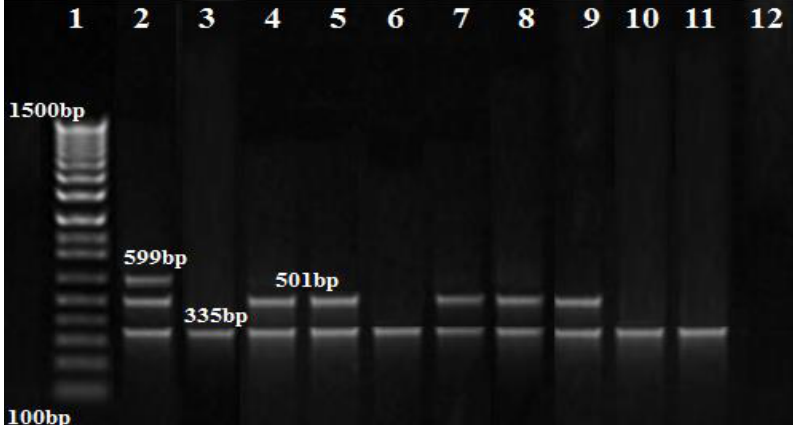
Figure 3. Agarose gel image showing the separation of the OXA gene products amplified using multiplex PCR. Lane 1: DNA marker (100 bp ladder Biolabs Company, Cat.N3231S, London, England), lane 2: positive control, lane 3–11: positive for the bla OXA51 gene (335 bp), lane 4,5,7,8,9: positive for the bla OXA23 gene (501 bp); no band was seen for bla OXA58 (599